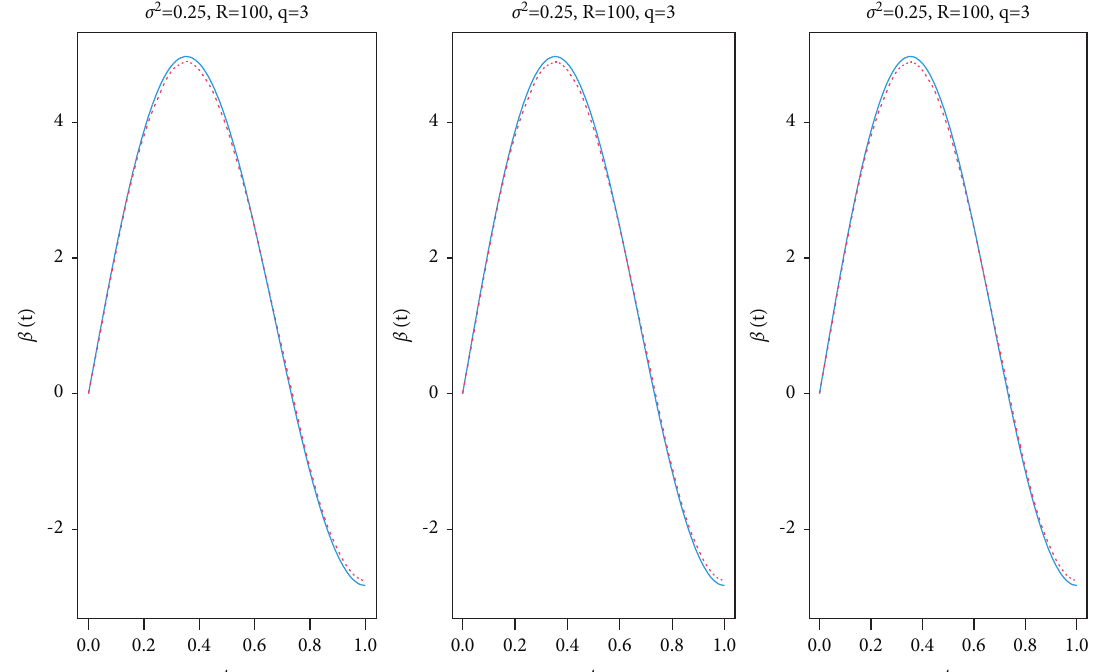
Figure 2: The estimated functional coefficient versus true value of β ( t ) with different ρ s (from left to right responding to ρ � 0 . 5 , 0 , − 0 . 5) when R � 100 ,q � 3 , and σ 2 � 0 .